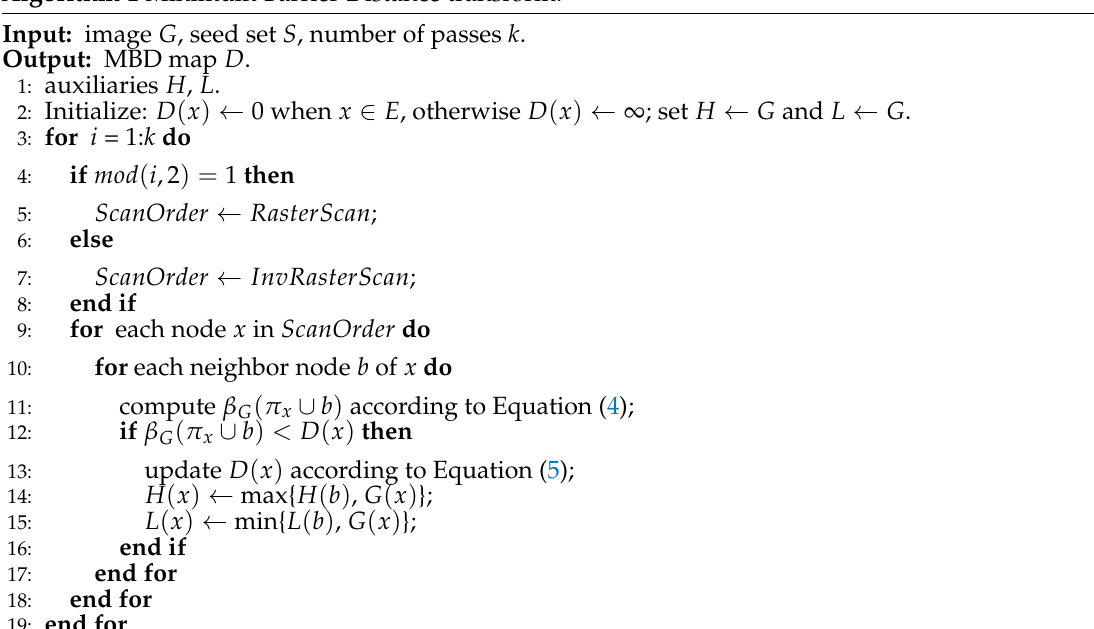
Algorithm 1 Minimum Barrier Distance